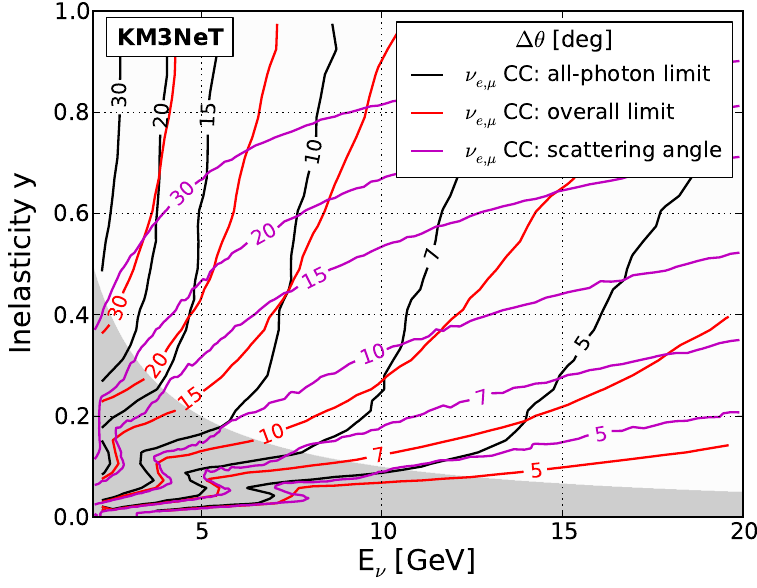
Figure 12 . Limitations on neutrino direction resolution (68% quantiles) in , - (cid:23) e;(cid:22) CC events as a function of neutrino energy E (cid:23) and inelasticity y , in both the all-photon limit (black) and the overall limit (red). This is compared to the intrinsic scattering angle between the outgoing lepton and the neutrino (purple). The region E h < 1 GeV (grey shading) has been calculated using extrapolated hadronic cascade results, and should be interpreted with care. The ‘kinks’ in the bottom-left corner are due to a change in recoil mass (di(cid:11)erent interaction channels) and therefore di(cid:11)erent values of E h = j ~p h j .